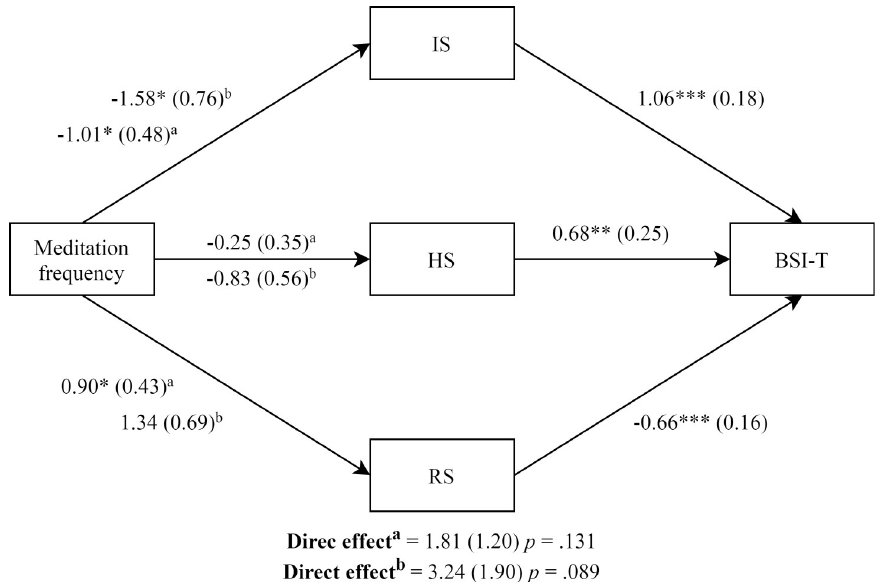
Fig 2. Influence of meditation practice on general distress through self-criticism. IS = Inadequate self; HS = Hated self; RS = Reassured self. a = Meditators vs. non-meditators. b = Non-active Meditators vs. non-meditators � p < .05. �� p < .01. ��� p < .001.